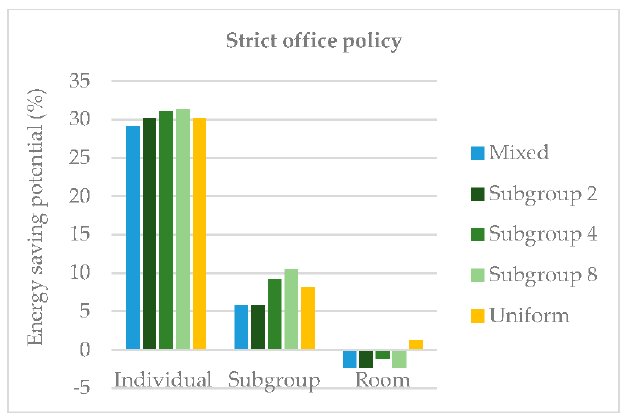
Figure 12. Energy saving potential of the three control strategies for the five function distributions with a strict office policy.